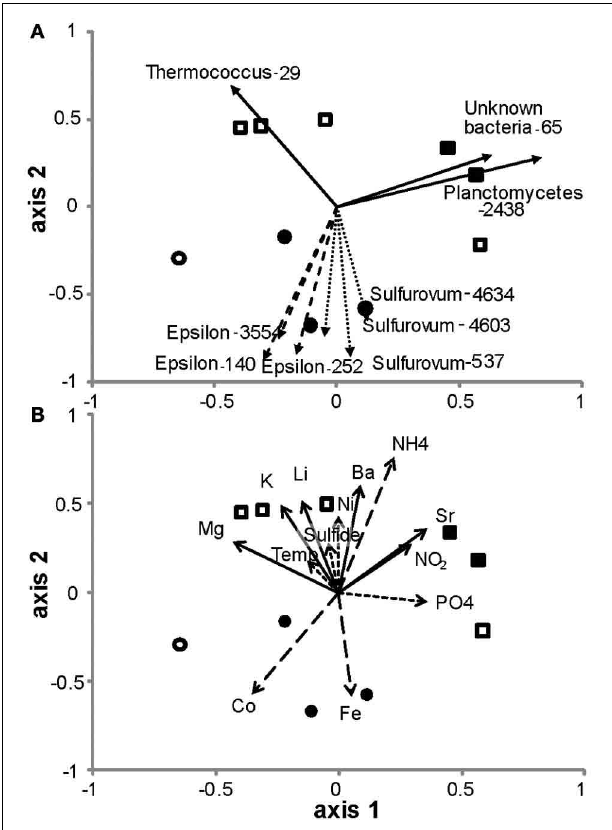
FIGURE 7 | Non-metric multidimensional scaling plot of hydrothermal vent microbial communities. (A) Vectors of the correlation values from OTUs that most explain the relationships in the plot ( r > 0 . 6, n > 2 . 0). (B) Vectors of the correlation values from environmental factors that most explain the relationships in the plot ( r > 0 . 2 and < 0 . 4 indicated as dotted lines, r > 0 . 4 and < 0 . 6 indicated as solid lines and r > 0 . 6 as dashed lines). Circles, 9 ◦ N East Pacific Rise; squares, Guaymas Basin; closed symbols, macrofauna-associated; open symbols, not